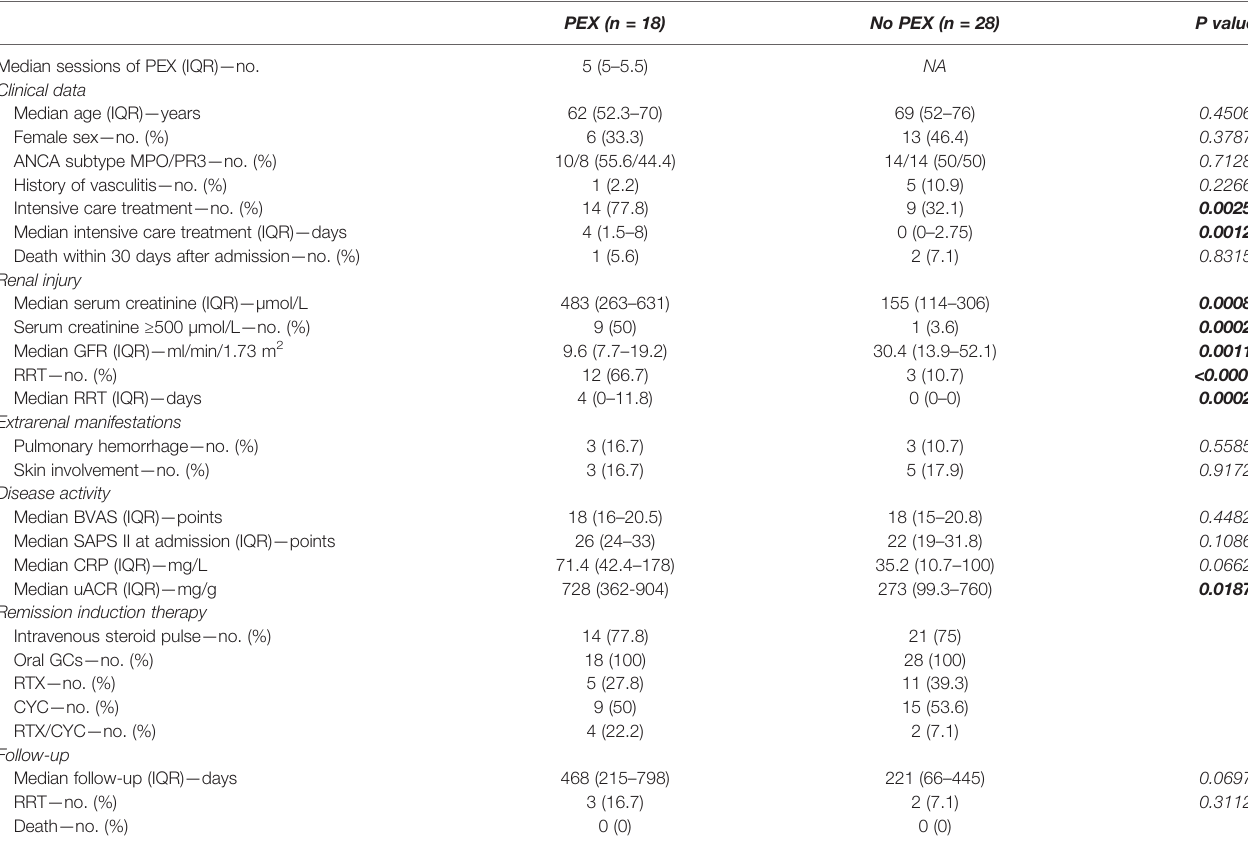
PEX (n = 18) No PEX (n = 28) P value